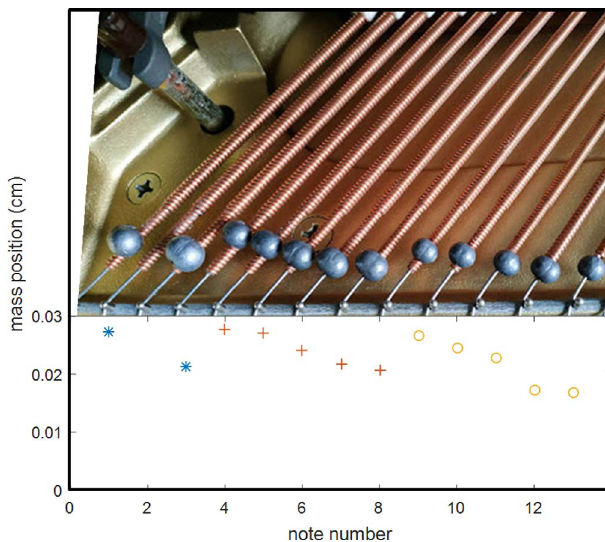
Figure 8. Theoretical location of added masses for each note (* 10 g; + 5 g; o 2.5 g). Picture: effective location of the masses (the image has been turned upside down to allow comparison with the